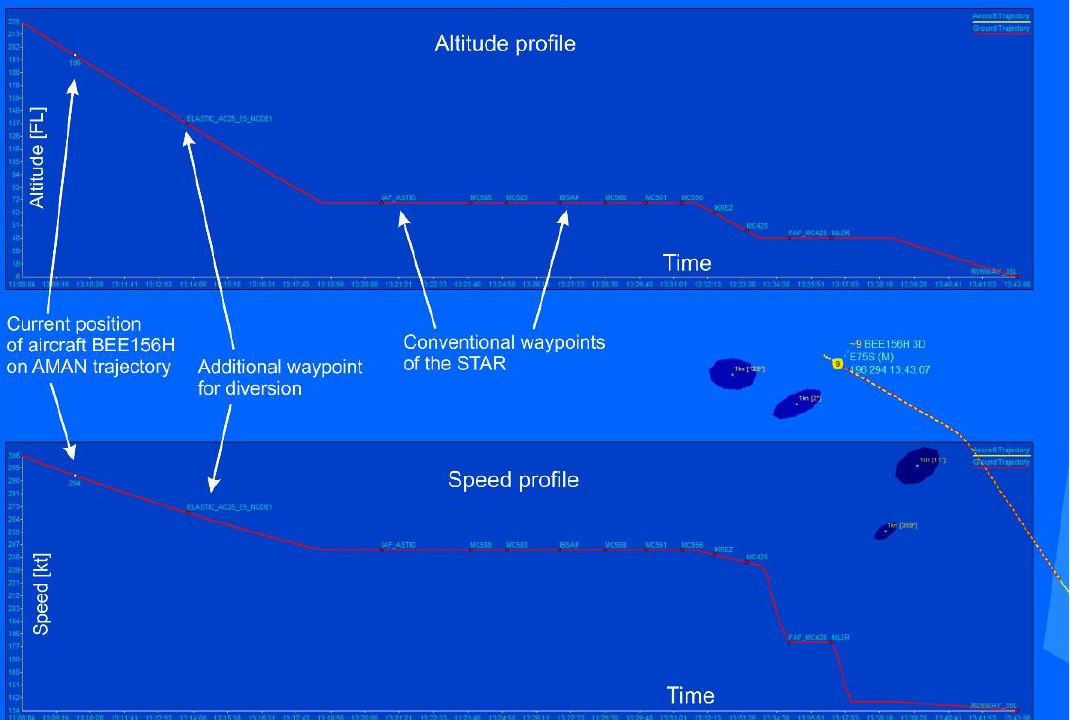
Figure 22. Visualization of an AMAN-calculated 4D diversion trajectory for aircraft BEE156H approaching MXP from the west and currently ninth in the arrival sequence. In the upper dark blue shaded diagram, the altitude profile is displayed, and in the lower one the speed profile is displayed. It can be seen that the aircraft is already descending as it flies around the thunderstorm cell. MXP traffic mix from 11 May 2019 with weather from 11 May 2019 and the PhaSt nowcast model.